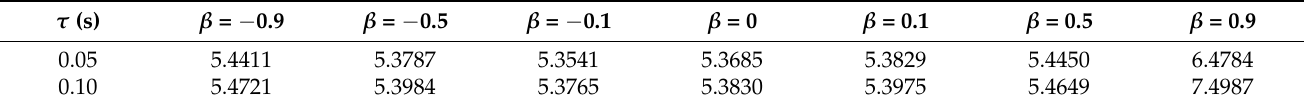
delays and different fractional orders in the proposed controller.